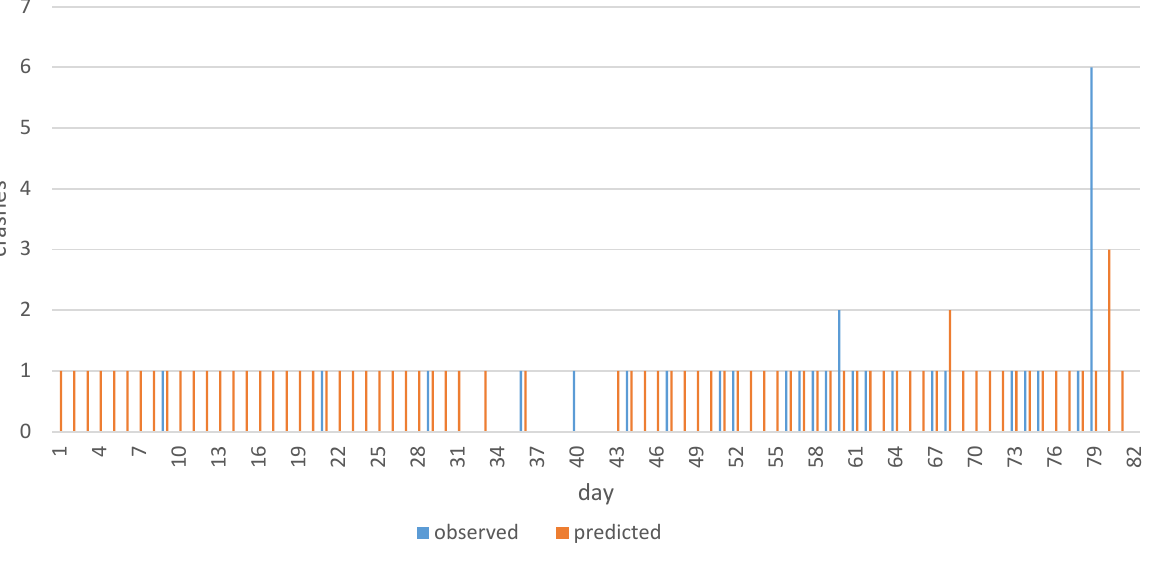
Figure 8. Prediction in Soochow direction of NB Count Data Figure 10. Prediction in Soochow direction of NB Count Data Model. Figure 10. Prediction in Soochow direction of NB Count Data Model.